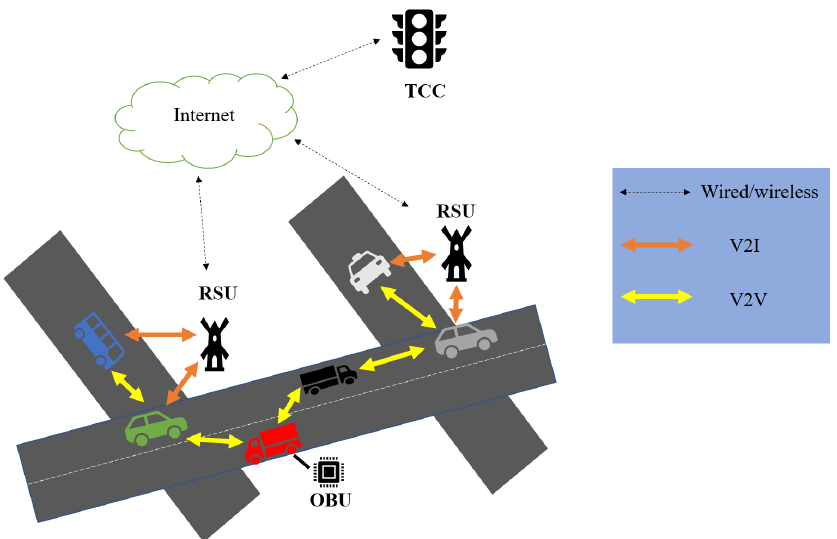
Figure 1. A typical VANET